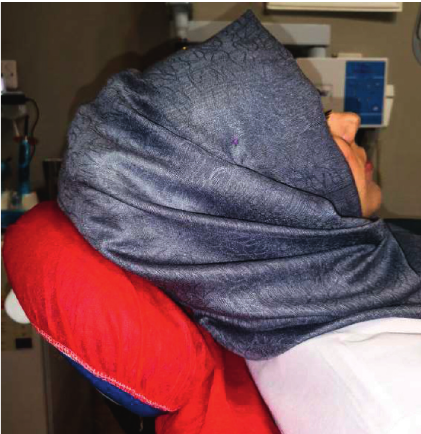
Figure 1: Head position on dental chair of a female patient wearing large hair clip underneath the